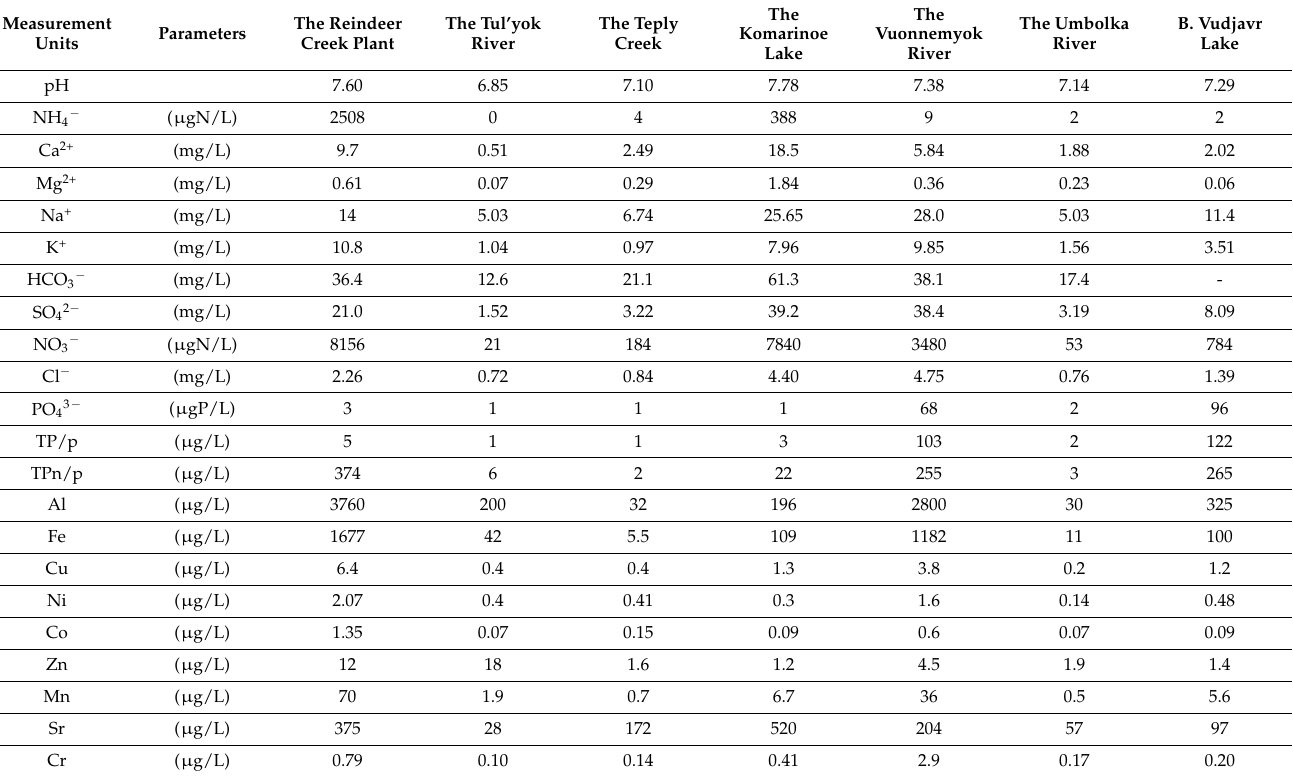
Table 2. Hydrochemical parameters of water of collection sites.